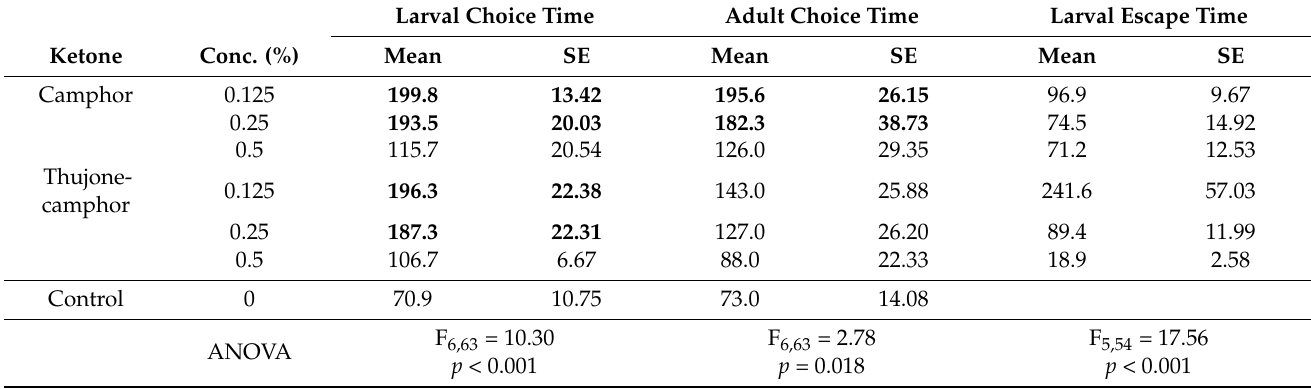
Table 3. The time needed for the insects to choose and move towards the control leaf disc in the olfactometer and the time needed to escape after contact with the treated leaf disc depending on the ketone type and concentration. F, p values were obtained from one-way ANOVA. Significant differences from the control group are marked in bold (Dunnett test, p <